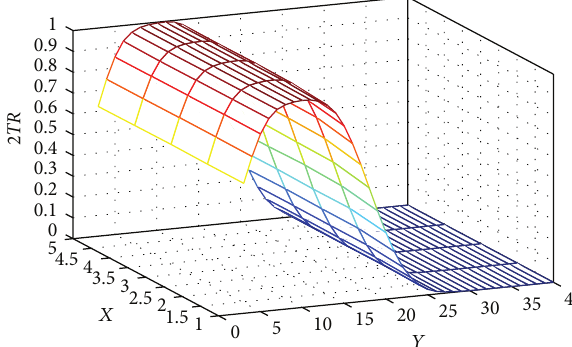
Figure 6: Sensibility of parameter 𝛼 .